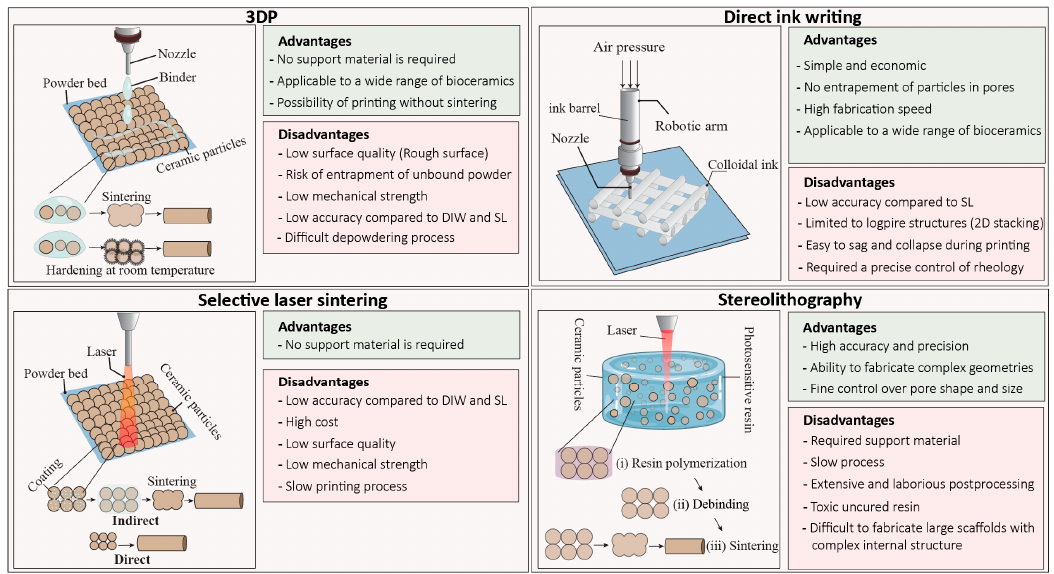
Figure 1. Schematic of common additive manufacturing techniques including 3D printing (3DP), direct-ink writing (DIW), stereolithography (SL), and selective laser sintering (SLS) for printing bioceramic scaffolds and their advantages and disadvantages.